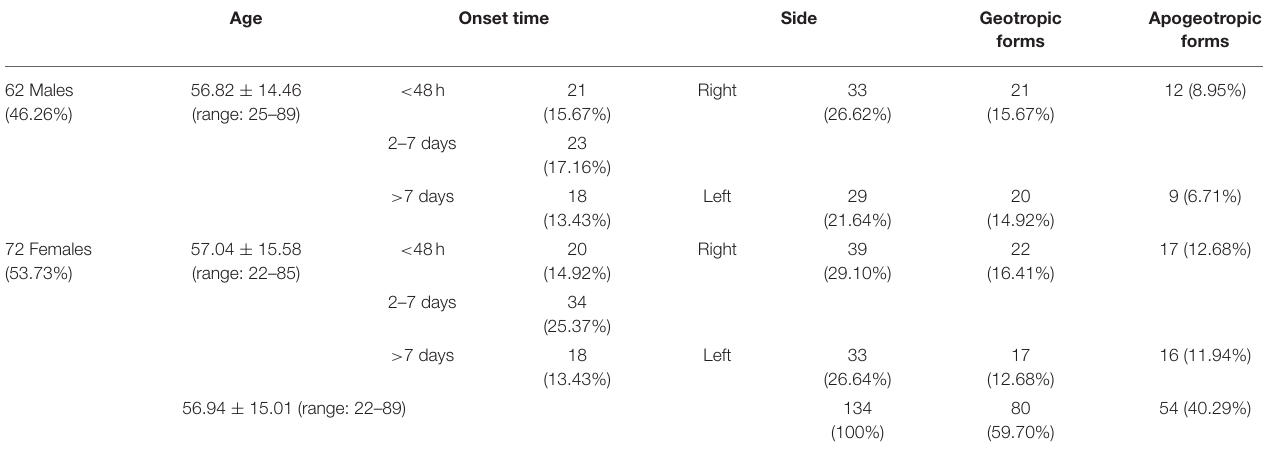
TABLE 1 | Demographic